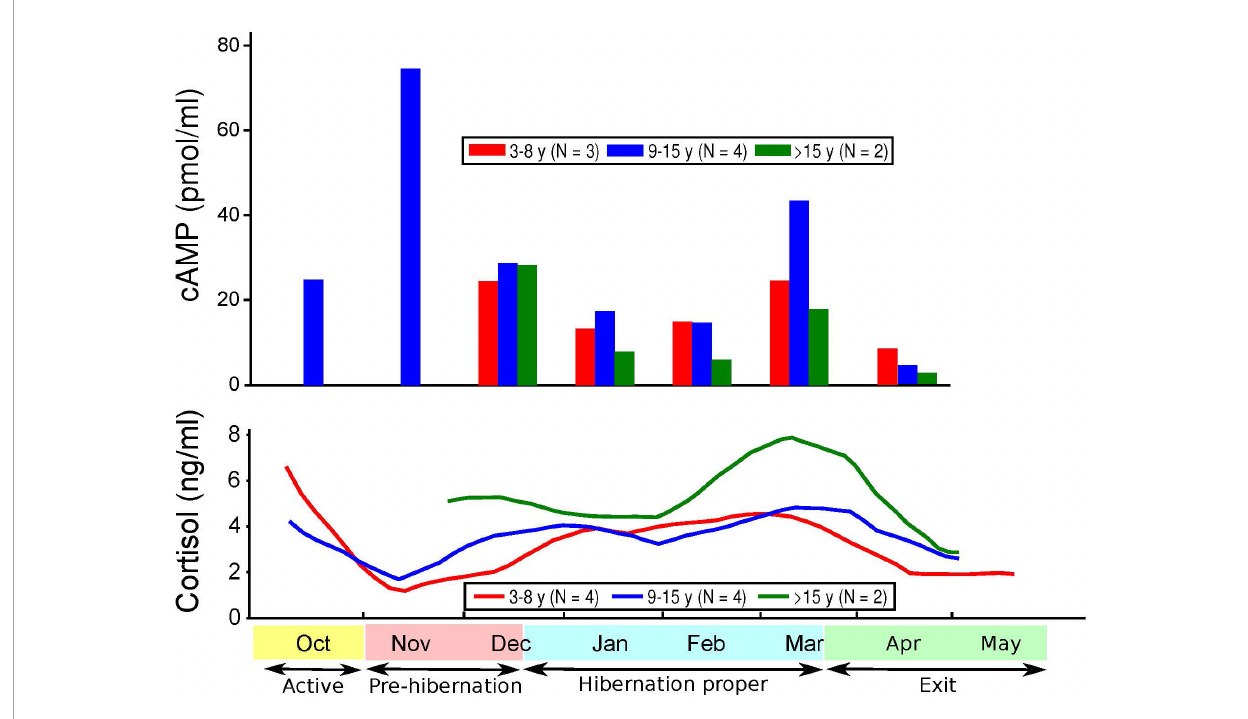
FIGURE3 Levels of cyclic adenosine monophosphate (cAMP) and cortisol over time and age of